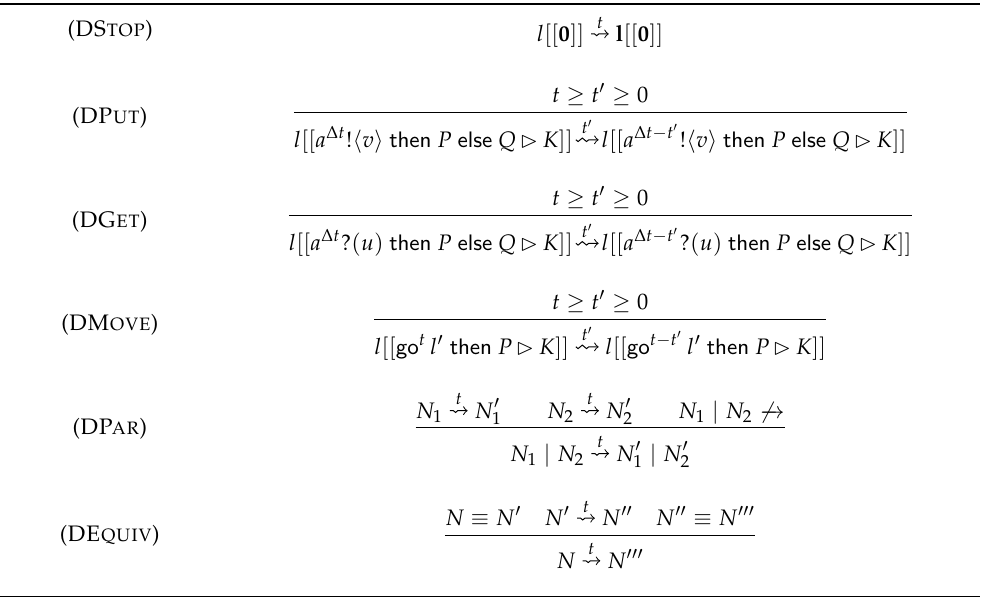
Table 3. Operational Semantics of knowT I M O : Time